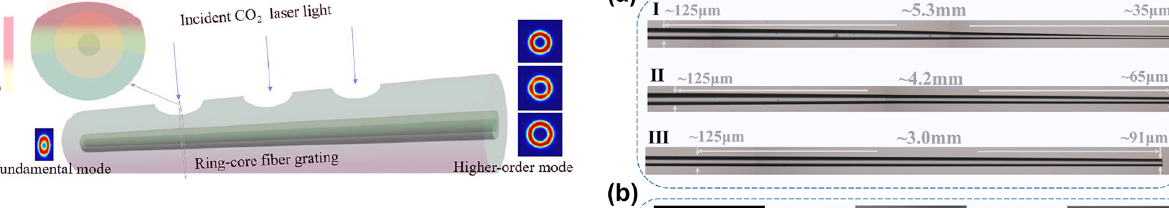
Figure 4: Schematic diagram of LPFG inscribed in the RCF.